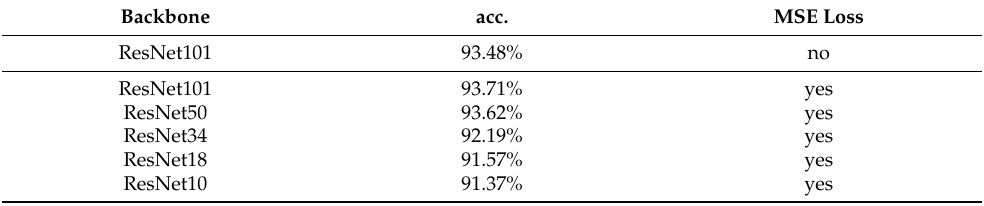
Table 3. Results on Class Activation Intervals (CAIs) using MSELoss+CELoss while changing the bottom-up backbone ConvNet. All the models were trained on the Munich dataset for 300